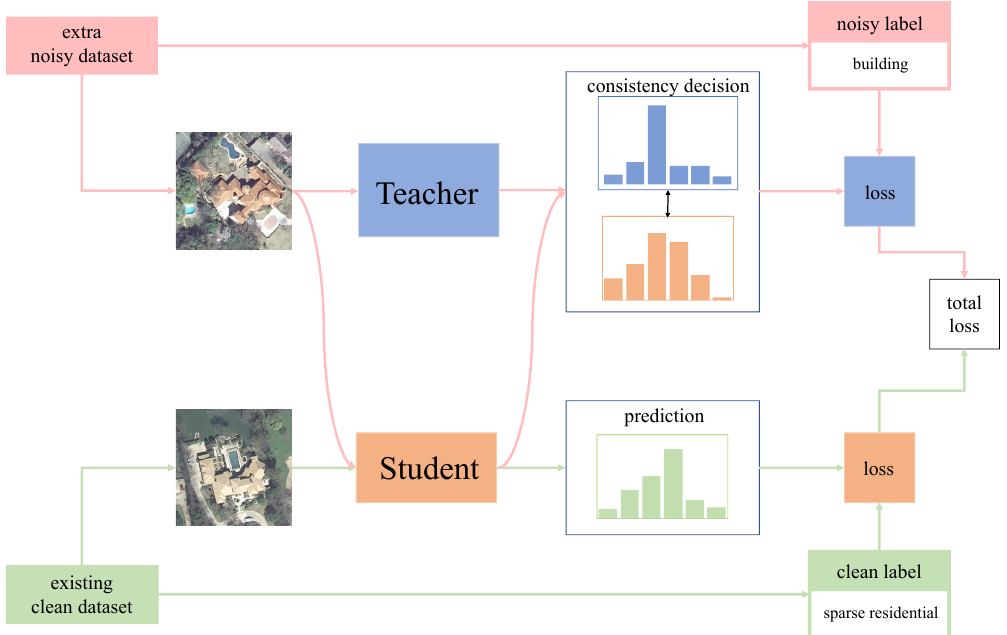
Figure 1. A high-level illustration of NLD. The student and teacher mutually learn knowledge of clean and noisy